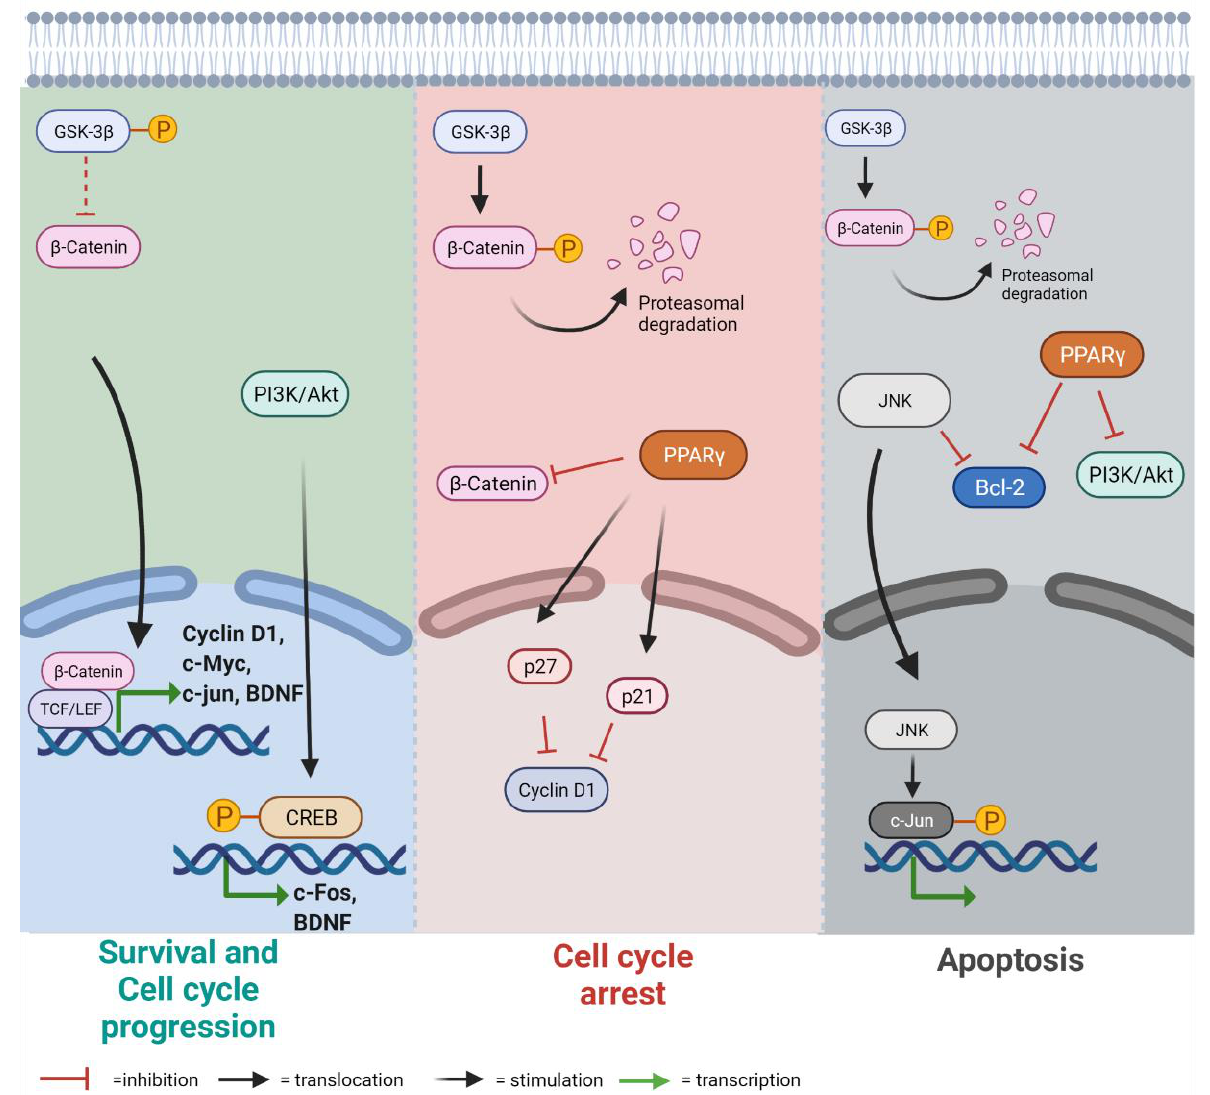
Figure 1. Schematic representation of the signaling pathways involved in survival and cell cycle progression, cell cycle arrest, and apoptosis affected by Lamin B1 overexpression. Created with Biorender.com.